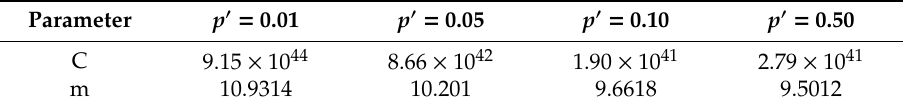
Table 2. Parameter values under different damage probabilities.